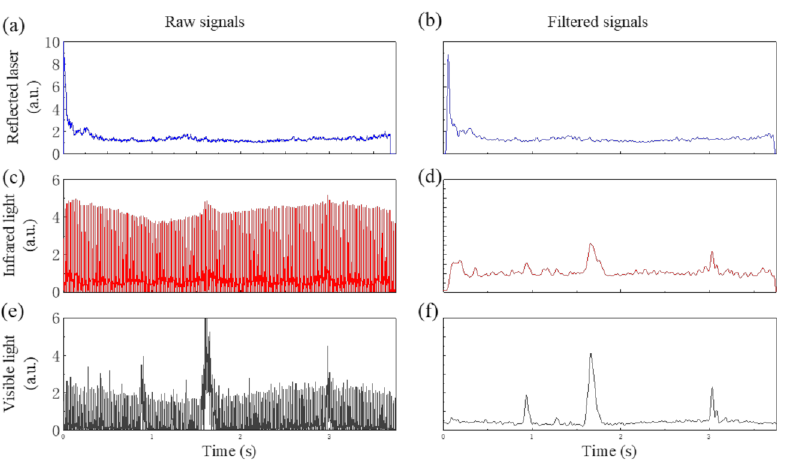
Figure 6. Raw and filtered signals of visible light, infrared light, and reflected laser: ( a ) raw signals of reflected laser, ( b ) filtered signals of reflected laser, ( c ) raw signals of infrared light, ( d ) filtered signals of infrared laser, ( e ) raw signals of visible light, ( f ) filtered signals of visible